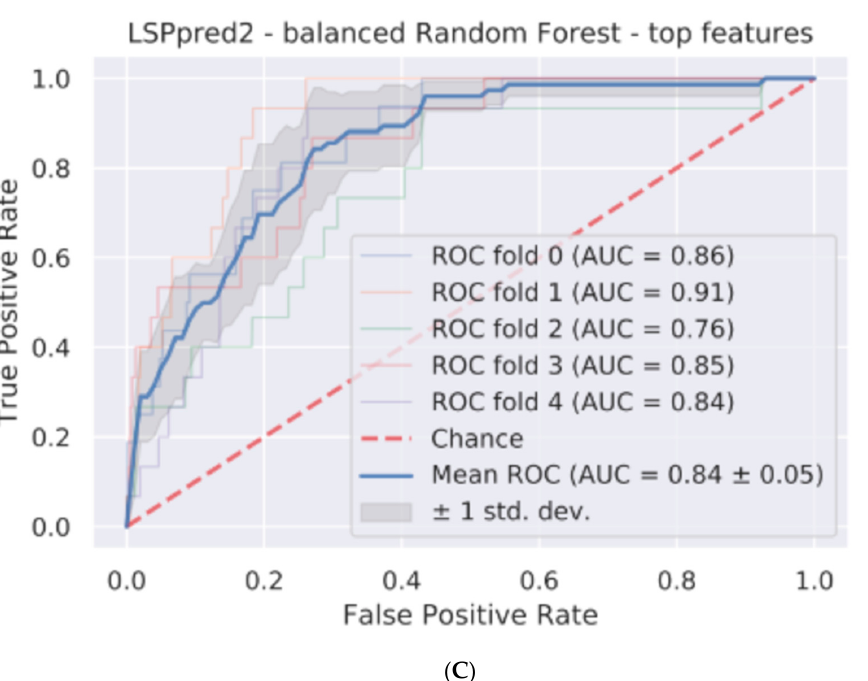
Figure 3. LSPpred and SPLpred. ( A ) Training data used for LSPpred and SPLpred, with subsets of the LSPDB classifications indicated as members of observed or unobserved, and secretory features or no secretory features. The application for SPLpred and LSPpred is also shown, with each subset labelled according to its use as positive data (+ symbol), negative data ( − symbol) or evaluation data (? symbol). Modifications to the SP region are shown with dotted lines. ( B , C ) The results of LSPpred and SPLpred on held-out test data, with five-fold cross validated ROC scores and mean ROC annotated for the final random forest models, are shown in ( B ) SPLpred3 (AUC 0.90) and ( C ) LSPpred2 (0.84), respectively.